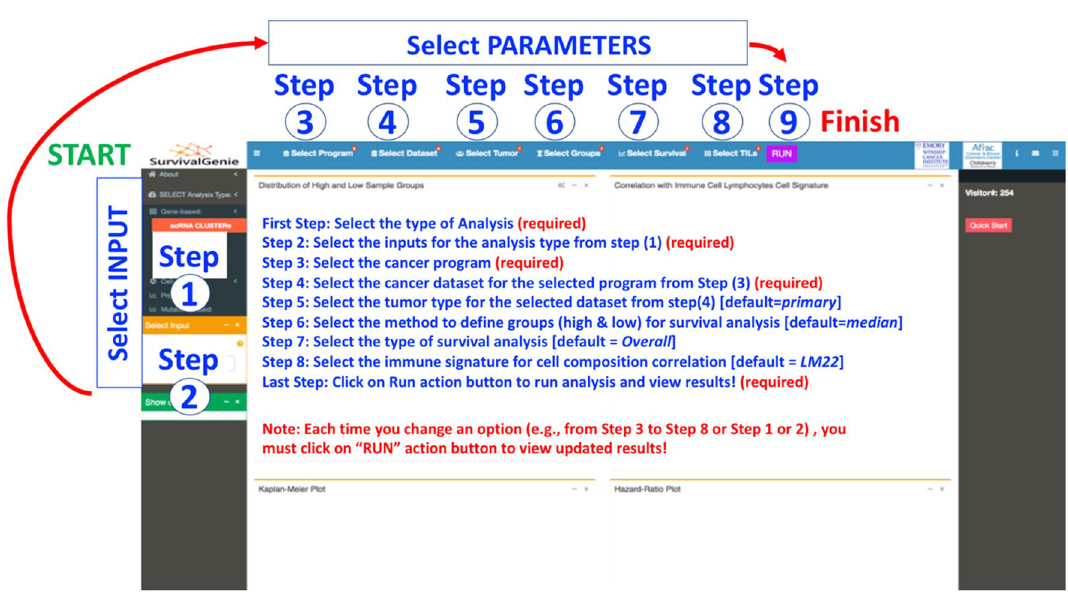
Figure 2. Summary of steps for performing survival analysis using the Survival Genie platform. Detailed instructions for analysis options and procedure are available in the demonstration tutorial video (https:// www. youtu be. com/ watch?v= H5s6O Yvwwoo) and the user manual on the GitHub site (https:// github. com/ bhasin- lab/ Survi valGe